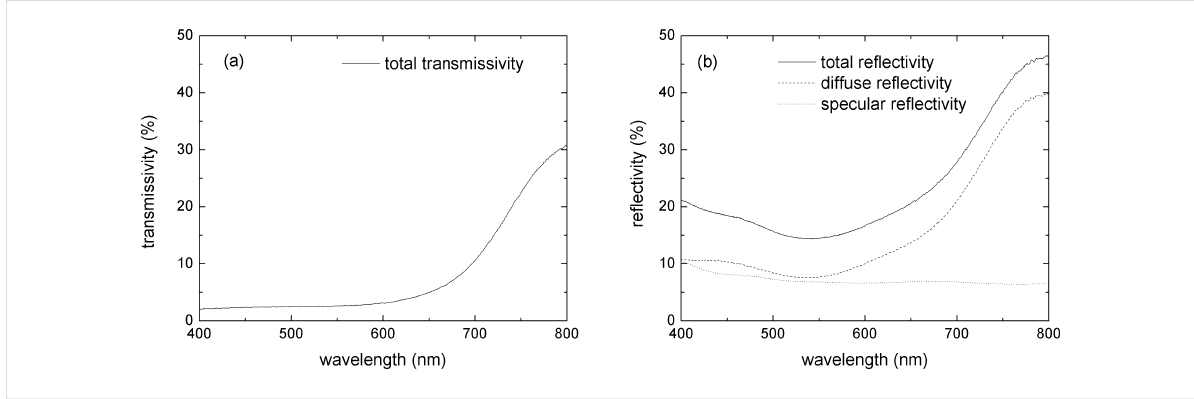
Figure 1: Experimental total transmissivity spectrum (a) and reflectivity spectra (b) of a 6.5 µm thick photoanode.